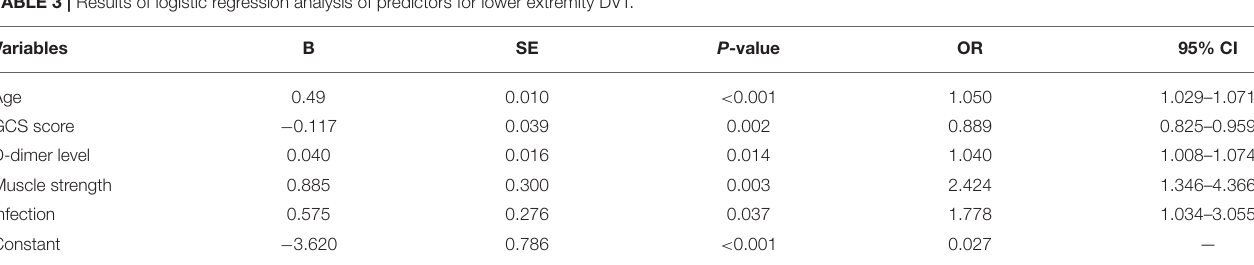
TABLE 3 | Results of logistic regression analysis of predictors for lower extremity